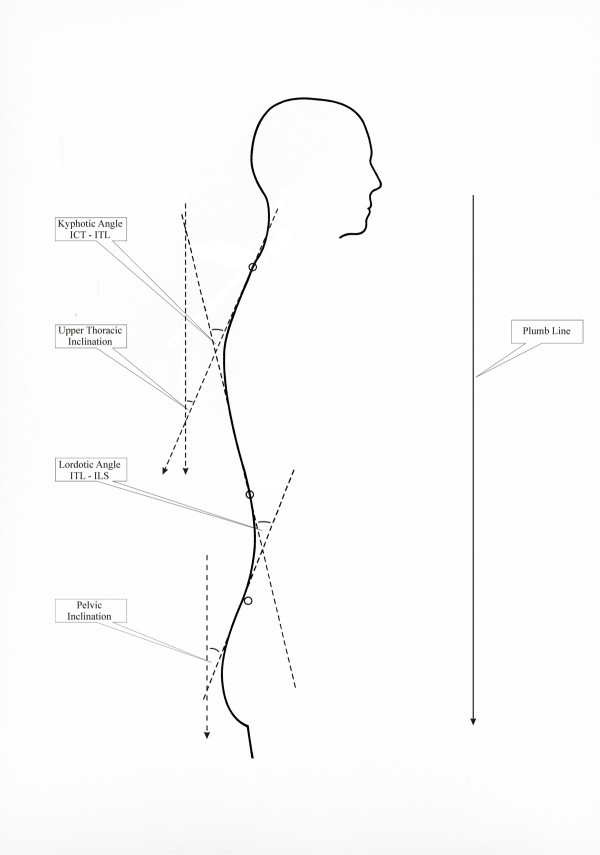
Lateral Profile Analysis derived from Rasterestereographic data. Outline of the sagittal profile. Three inflectional points along the profile are marked by open circles – the cervicothoracic (ICT), the thoracolumbar (ITL) and the lumbo-sacral inflection point (ILS). The tangents to the inflectional points span two characteristic angles of the profile – the kyphotic angle (KA) is spanned by the tangent lines in ICT and ITL; in an analogous way the lordotic angle (LA) is spanned by the tangents in ITL and ILS. Two other angles provide orientation data with respect to the vertical line (plumb line); 1) the angle of the upper thoracic inclination (UTI), which is virtually the angle spanned by the vertical and the ICT tangent, 2) the angle of the pelvic inclination (PI), virtually the angle spanned by the vertical and the tangent ILS